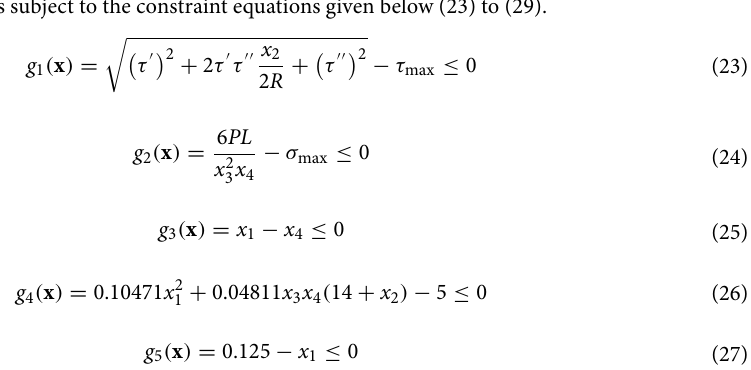
The objective function is subject to the constraint equations given below (23) to (29).